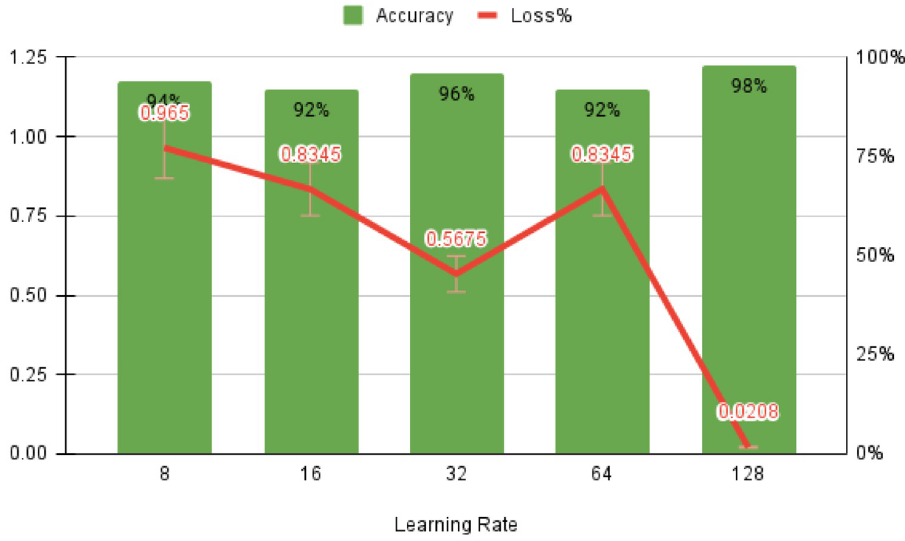
Fig 14. Accuracy as the function of minibatch